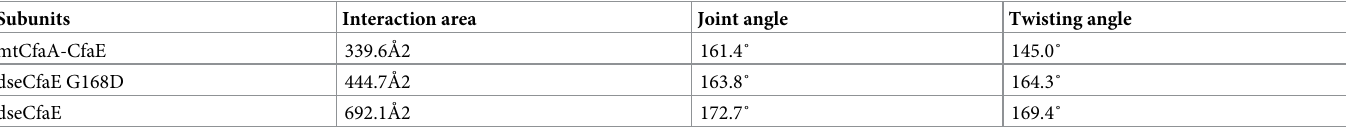
Table 3. Interdomain interface analysis as measured by interface area, joint and twisting angles between the adhesion domain (AD: Residues 23–200) and pilin domain (PD: Residues